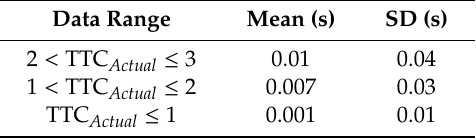
Table 10. Errors in the estimated TTC for the vehicle–pedestrian collision scenario.